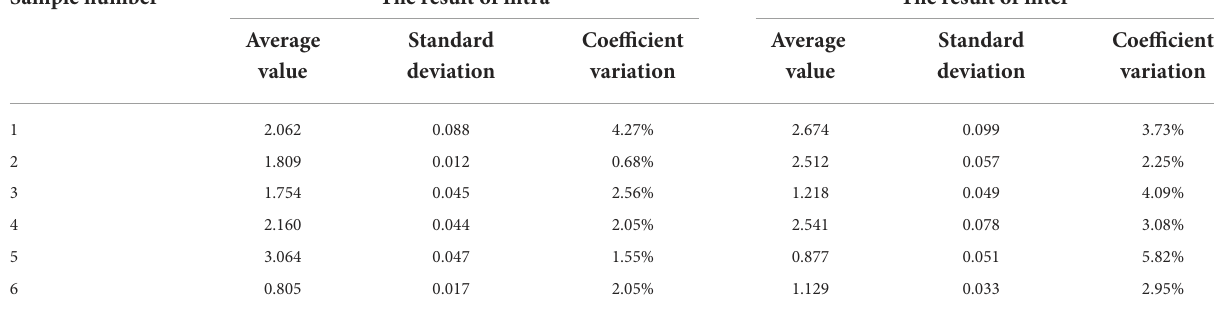
TABLE 3 The results of the repeating test.